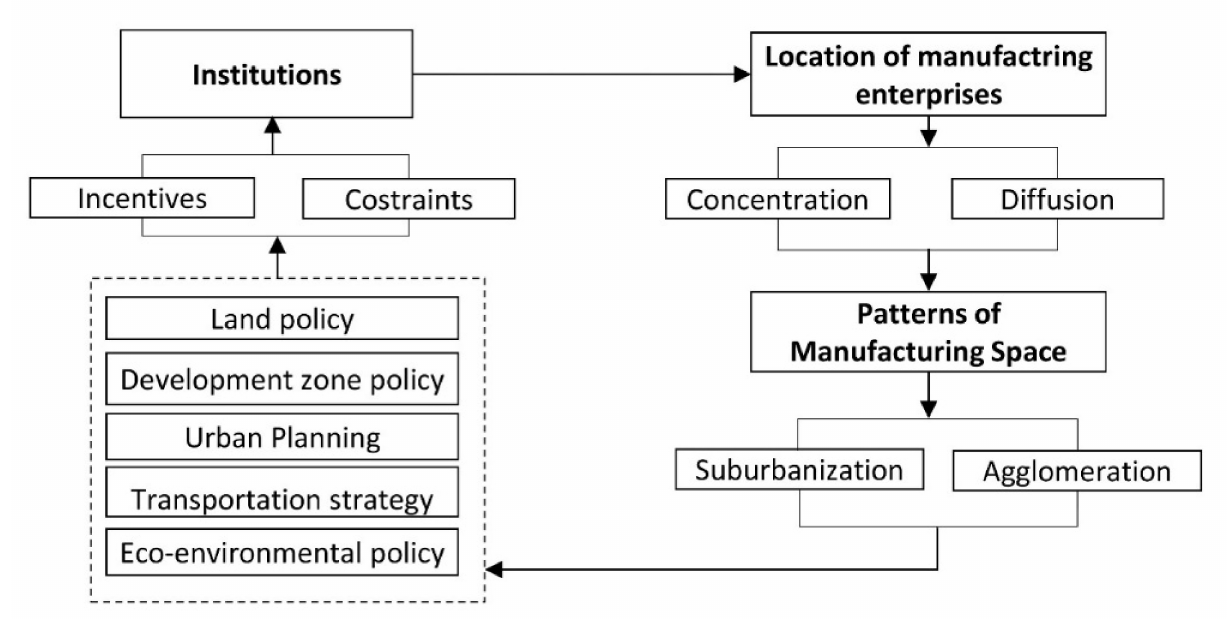
Figure 1. Framework of interpretation.